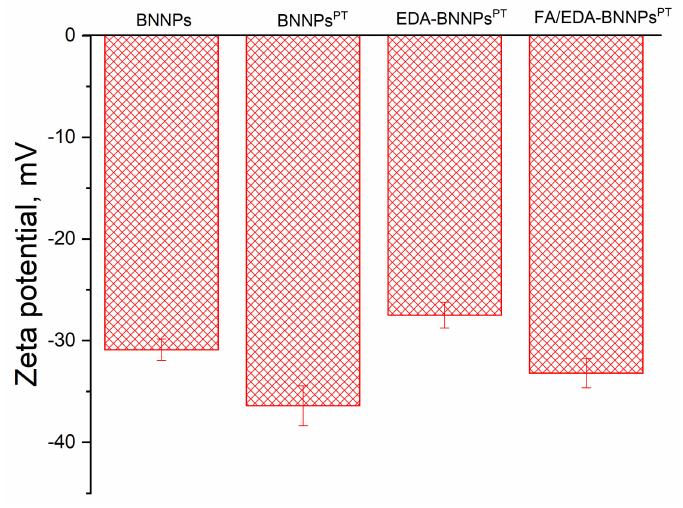
Figure 5. Zeta potentials of pristine and surface-functionalized